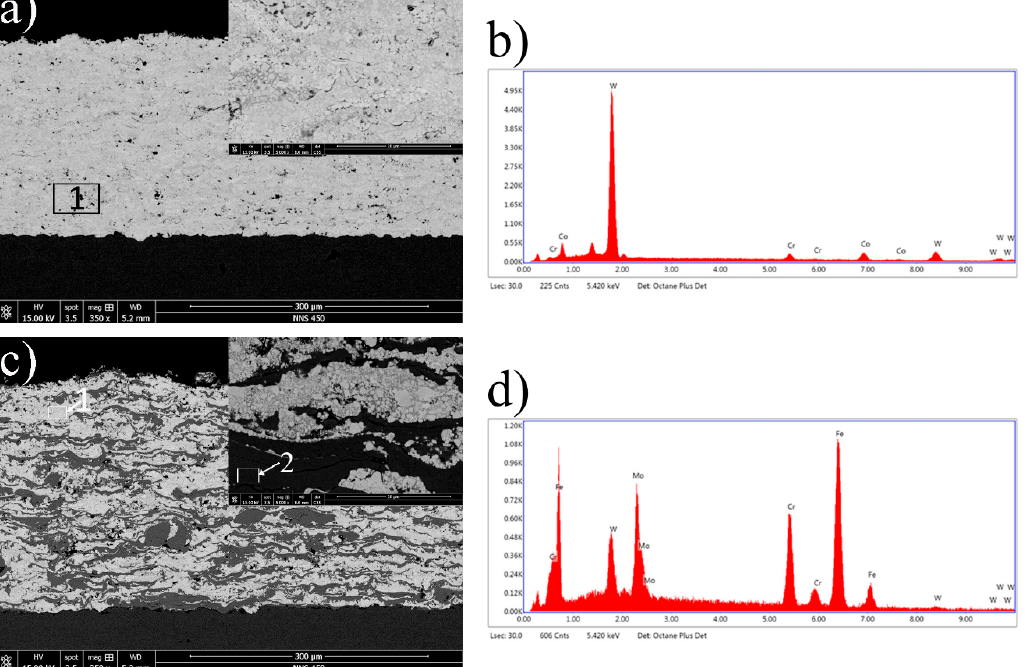
Figure 3. Backscattered electron SEM morphology of polished cross-section of the as-sprayed coatings and EDS analysis results. ( a ) WC–CoCr coating; ( b ) EDS analysis results on Area 1 of ( a ); ( c ) composite coating; and ( d ) EDS analysis results on Area 2 of ( c ).